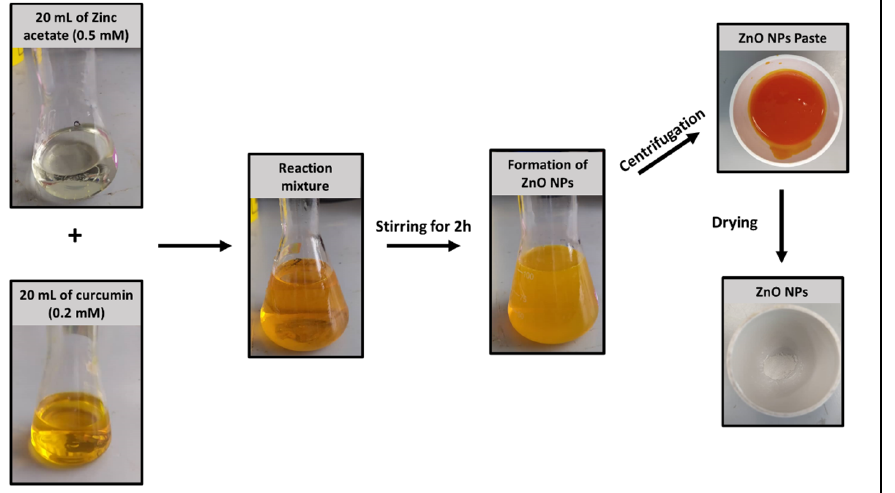
Figure 1. Synthesis scheme of Green ‐ ZnO ‐ NPs.